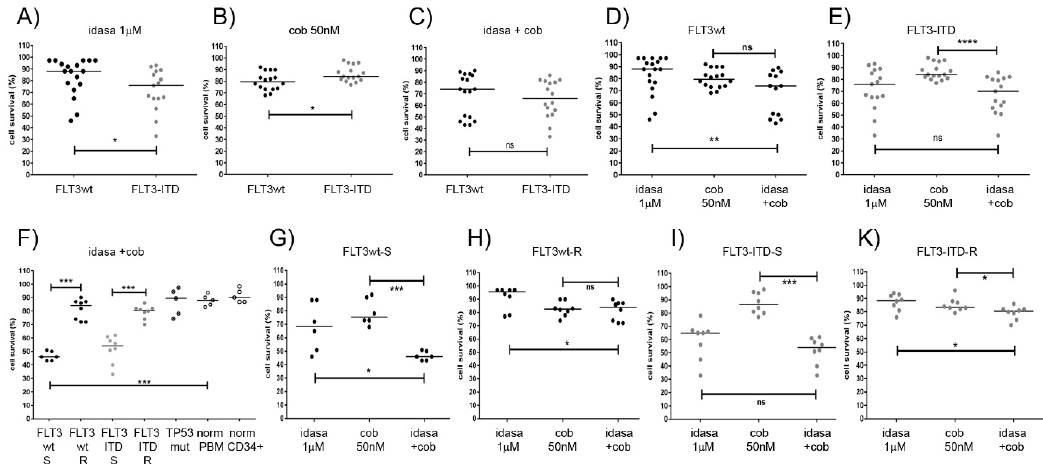
Figure 5 . Effects of idasanutlin and cobimetinib treatment on AML patient and normal blood samples. Cell viability assessments in AML patient cells treated for 24 h with idasanutlin and cobimetinib